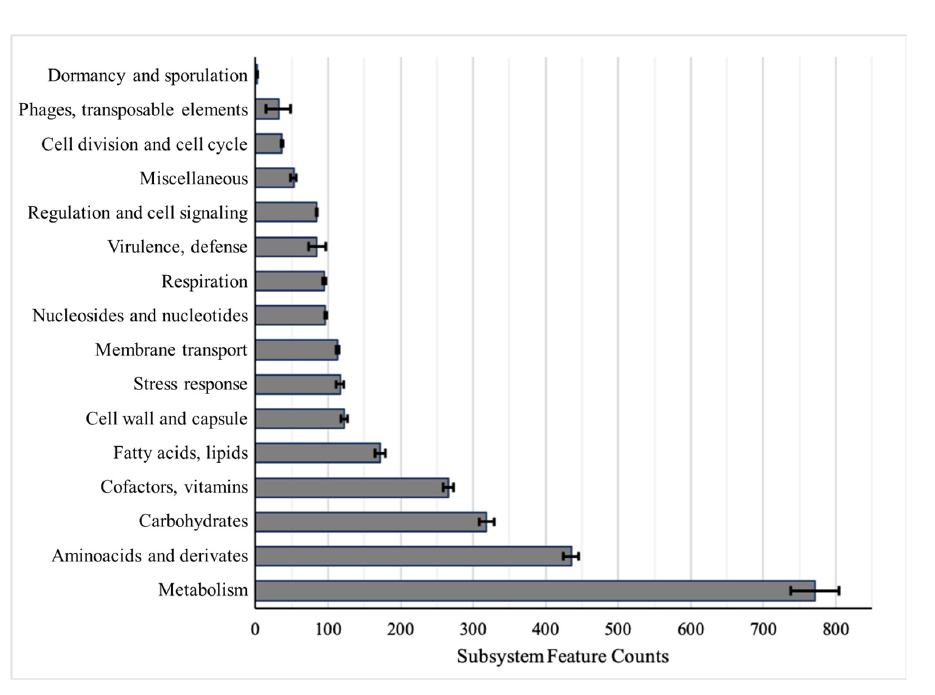
Figure 1. Protein-coding sequences included in each subsystem category . Each bar shows the aver- age of five strains ± SE (standard